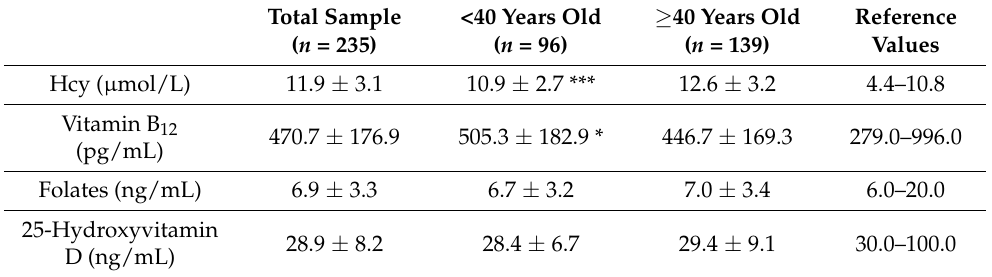
Table 6. Serum homocysteine, serum vitamin B 12 , serum folate, and serum vitamin D concentrations. Total Sample ( n =